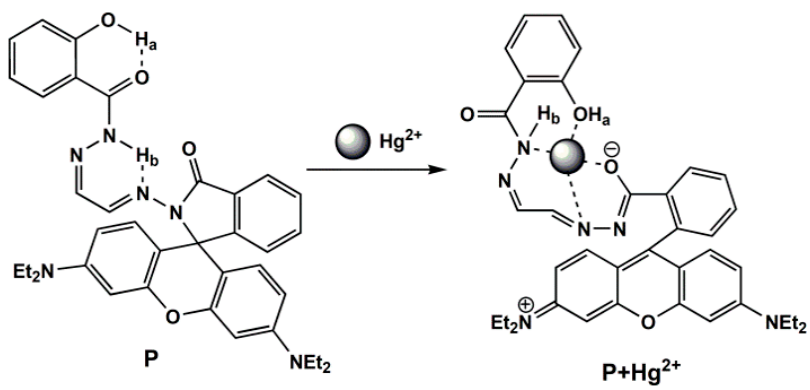
Scheme 2. The proposed binding mode of the P -Hg 2+ complex.